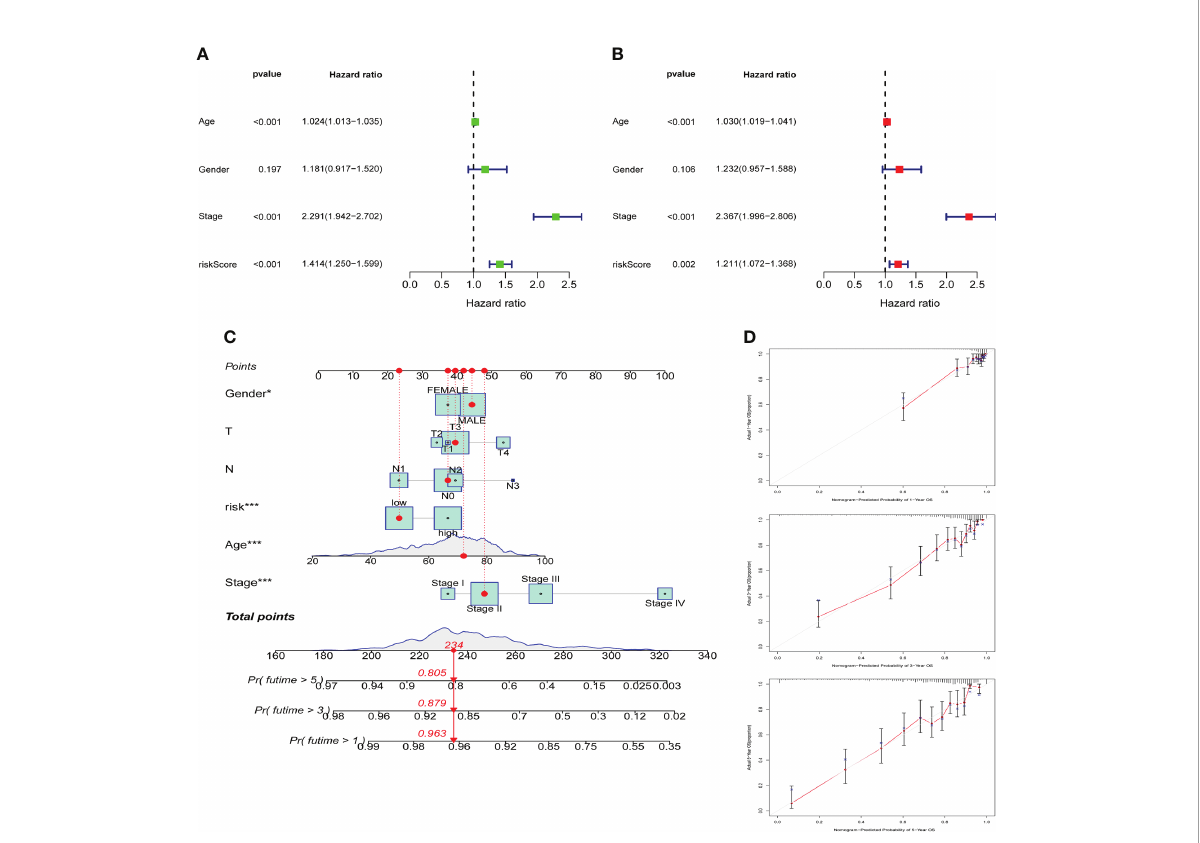
FIGURE 6 Construction and validation of a nomogram. Univariate cox regression (A) and multivariate cox regression (B) analysis of risk scores and clinicopathological factors. (C) Nomogram construction for predicting the 1-,3-,5-years OS of COAD patients. (D) Calibration curve analysis for predicting patients ’ survival at 1-,3-,5-year, the grey line represents the ideal performance, and the actual performance of the signature is represented by the red